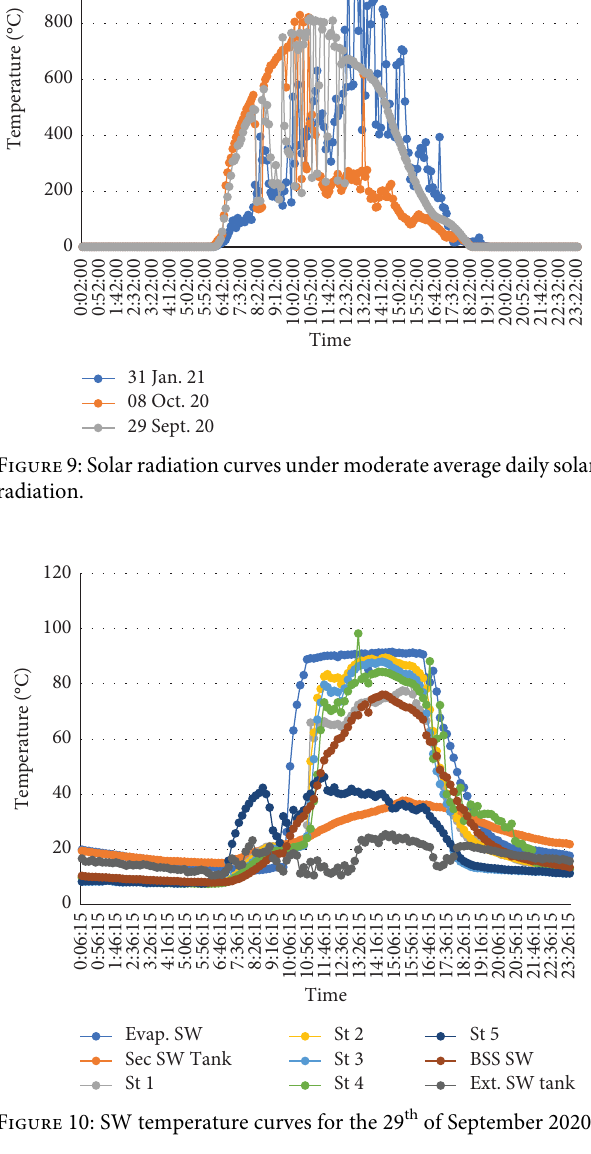
Figure 10. Te SW temperature diference between the secondary and external tank was 7.7 ° C, 11 ° C, and 11.2 ° C on the 29 th of September 2020, the 8 th of October 2020, and the 31 st of January 2021, respectively. Tere was a slight increase in the cumulative SW preheating and heat recovery com- pared to the low range of daily average solar radiation. Te